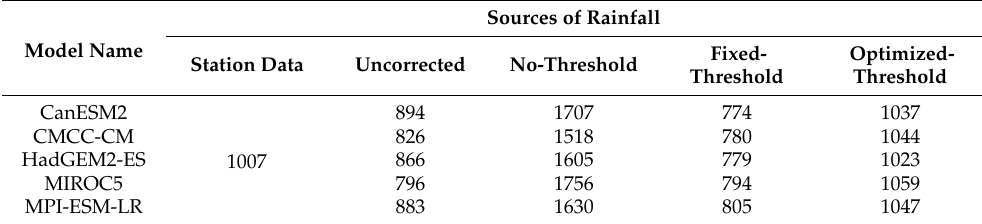
Table 6. Results of different rainfall sources (annual flow volume of watershed).